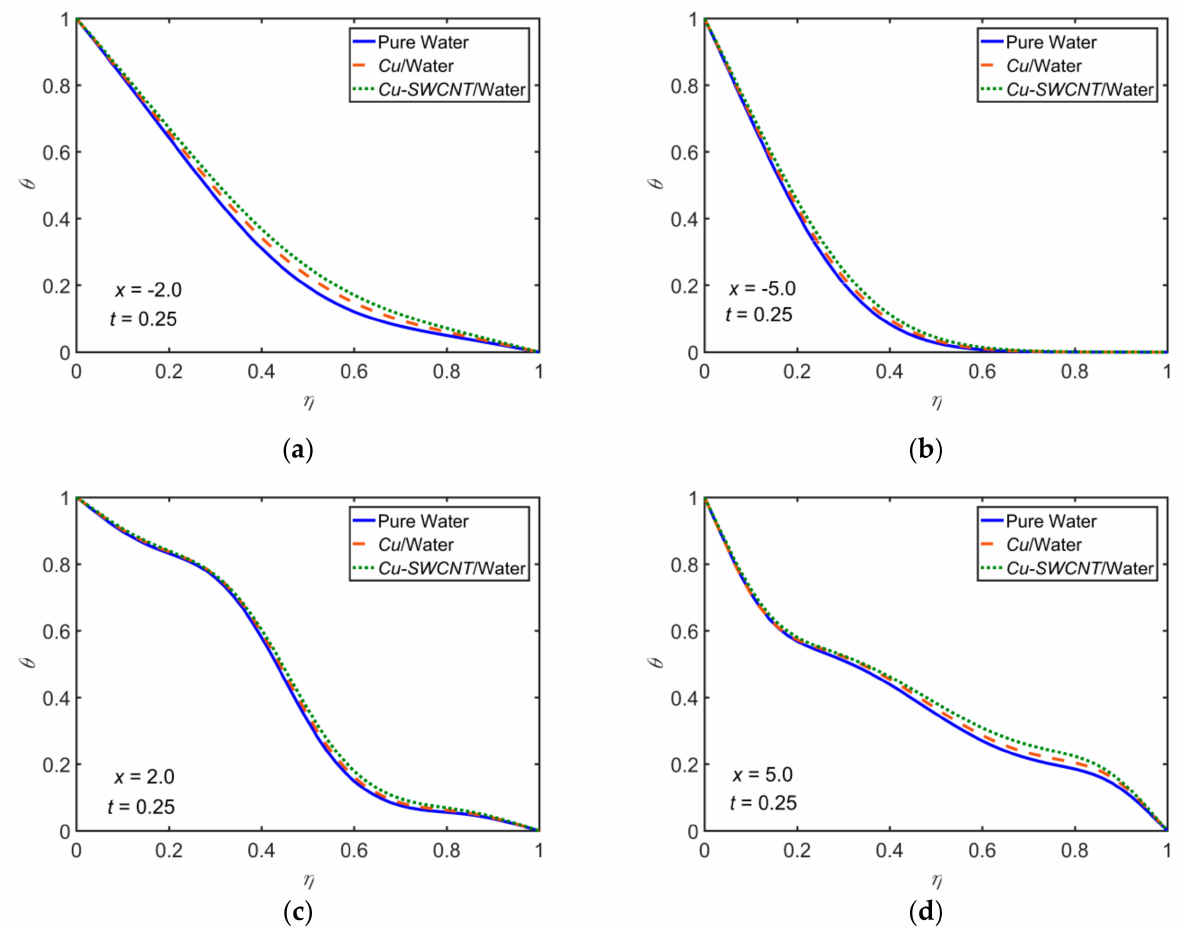
Figure 7. Comparison of pure water, Cu /water, and Cu – SWCNT /water for the temperature profiles for M = 5, Pr = 1, Rd = 0.2, Re = 700, φ = 0.02, and t = 0.25 at ( a ) x = − 5.0, ( b ) x = − 2.0, ( c ) x = 2.0, and ( d ) x = 5.0.